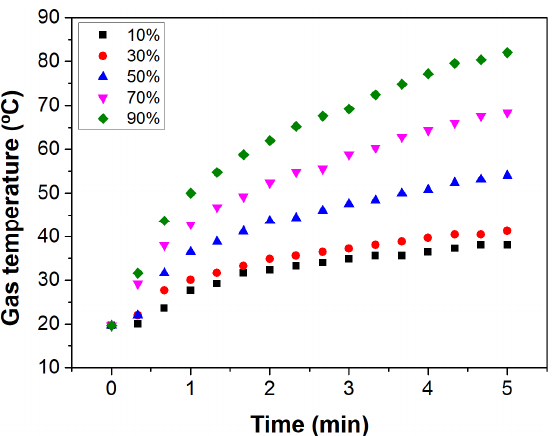
Figure 3. Temperature raised up to 5 min measured inside the reactor at the bottom central part of the glass Petri dish. A maximum error of ±0.5 °C for all data was considered.